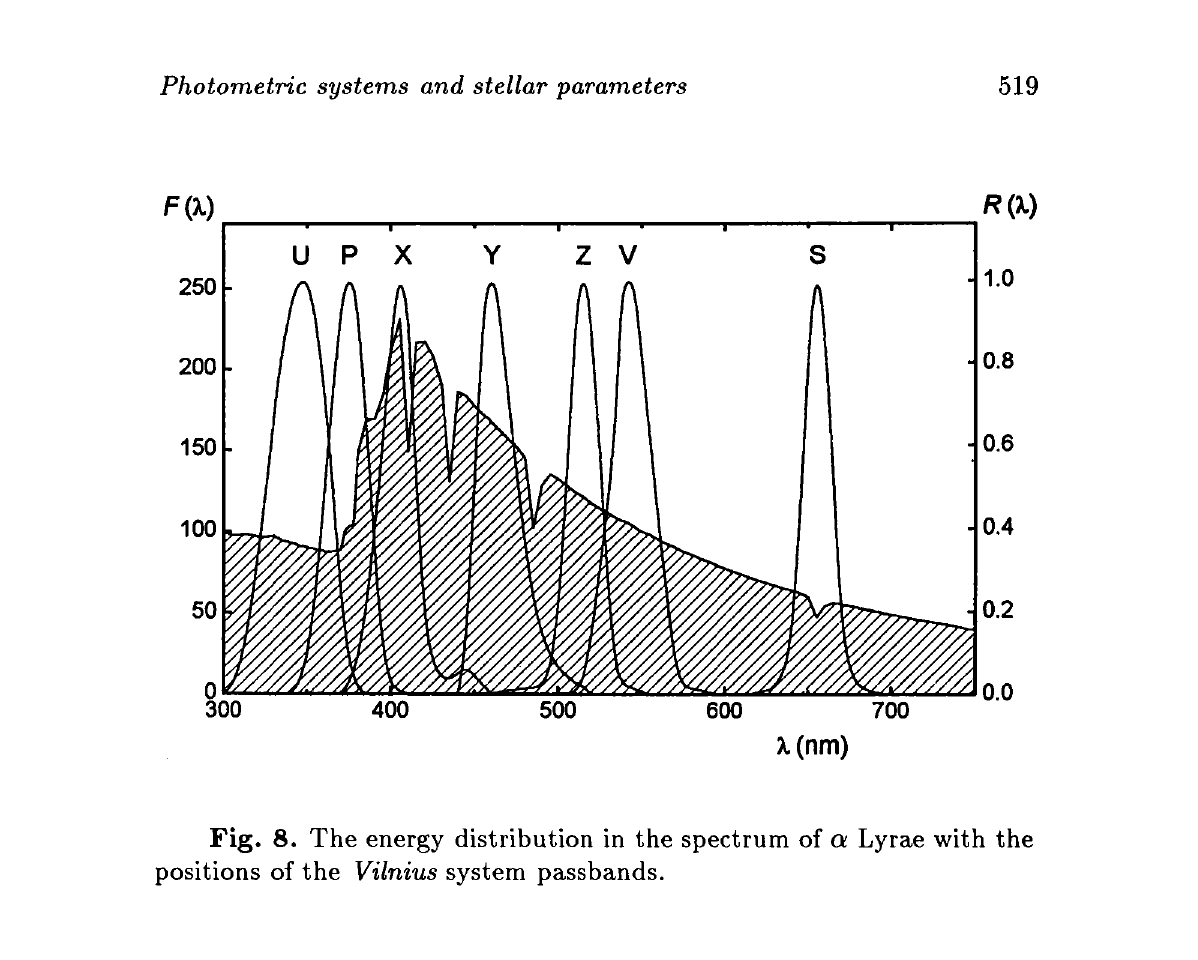
Fig. 8. The energy distribution in the spectrum of a Lyrae with the positions of the Vilnius system